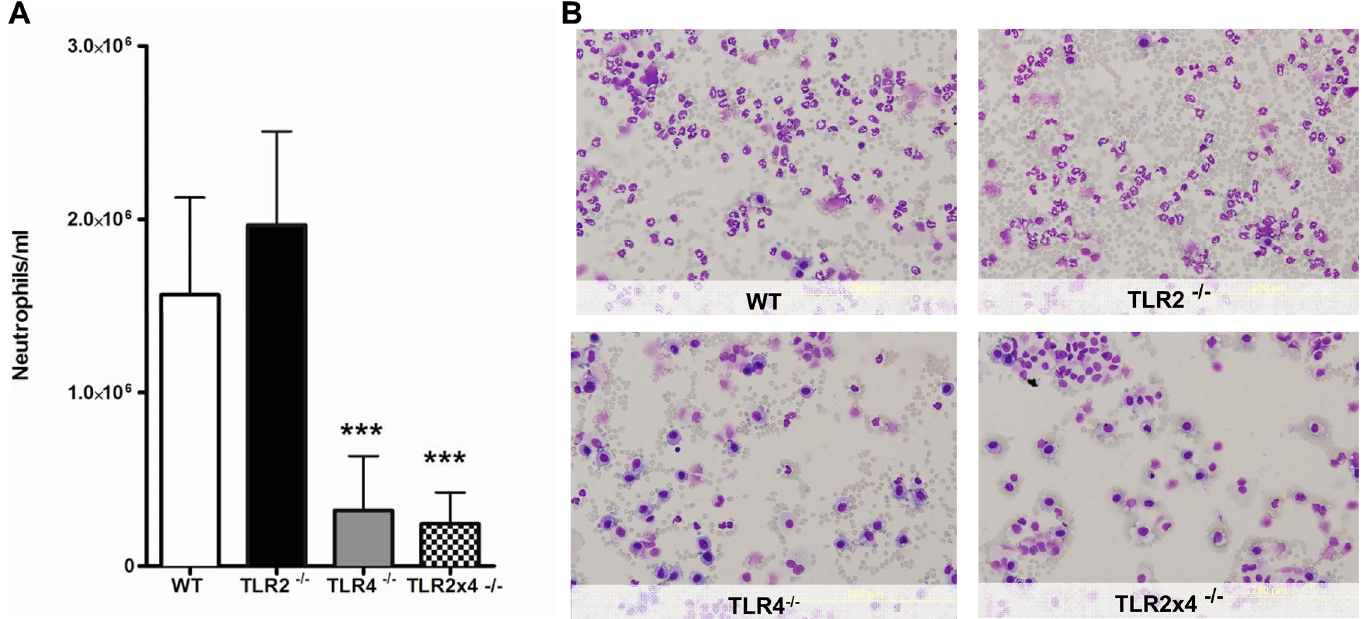
Fig 4. B . pseudomallei- LPS-induced neutrophil influx is dependent on TLR4 in mice. Wild-type ( WT), TLR2 -/- , TLR4 -/- and TLR2x4 -/- mice were inoculated intranasally with 10 ug LPS of B . pseudomallei 1026b and analysed 6h later for lung neutrophil influx in bronchoalveolar fluid (BALF) (A). Representative Giemsa stained BALF slides are shown of WT, TLR2 -/- , TLR4 -/- and TLR2x4 -/- mice obtained 6h post-LPS administration (magnification 20x) (B). Following a Kruskal-Wallis test, Mann-Whitney U-tests were performed. Data are presented as means ± SEM. Results of two independent experiments were pooled (n = 16 per group). *** P < 0.001 vs.